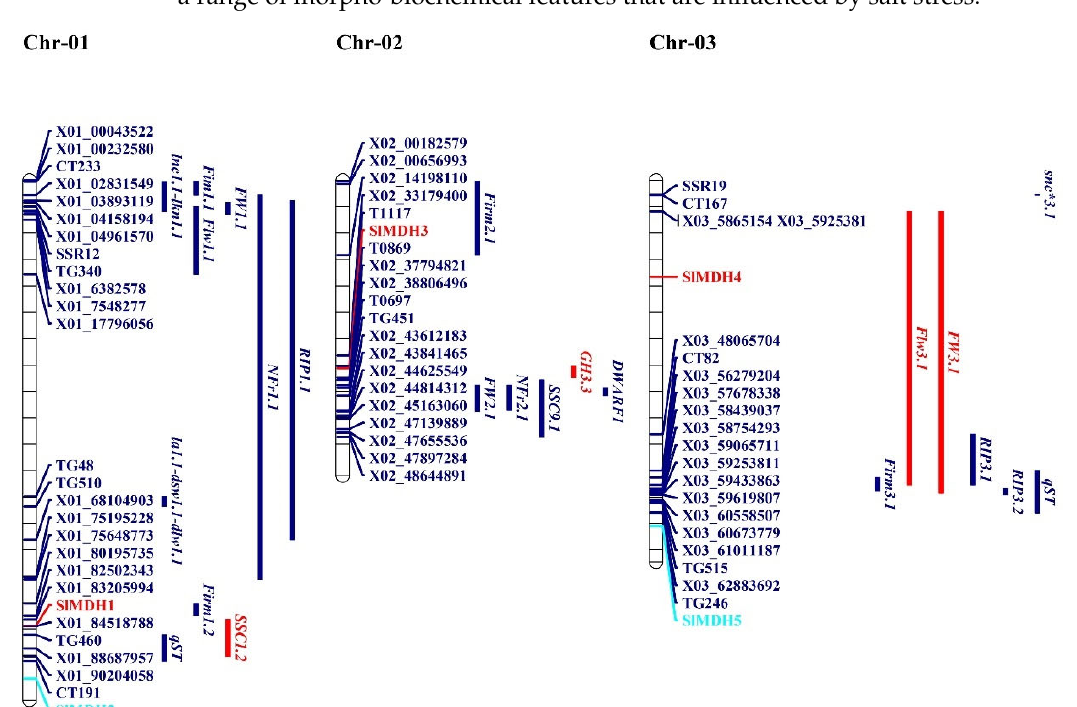
Figure 9. On the chromosomes of tomato, the MDH genes and the quantitative trait loci (QTLs) responsible for salt stress ‐ related traits were found to be in close proximity to one another. This scale illustrates the relative physical locations of genes and QTL ‐ linked markers in megabases (Mb). Genes located within the QTLs are illustrated with red color, while genes and QTLs not co ‐ localized are represented with turquoise and blue colors. 3. Discussion Malate dehydrogenases mediate the reversible conversion of malate to oxaloacetate and play critical roles in energy balance, plant growth, and cold and salt tolerance. MDHs are very active in plant cell and is required for numerous metabolic activities [14].